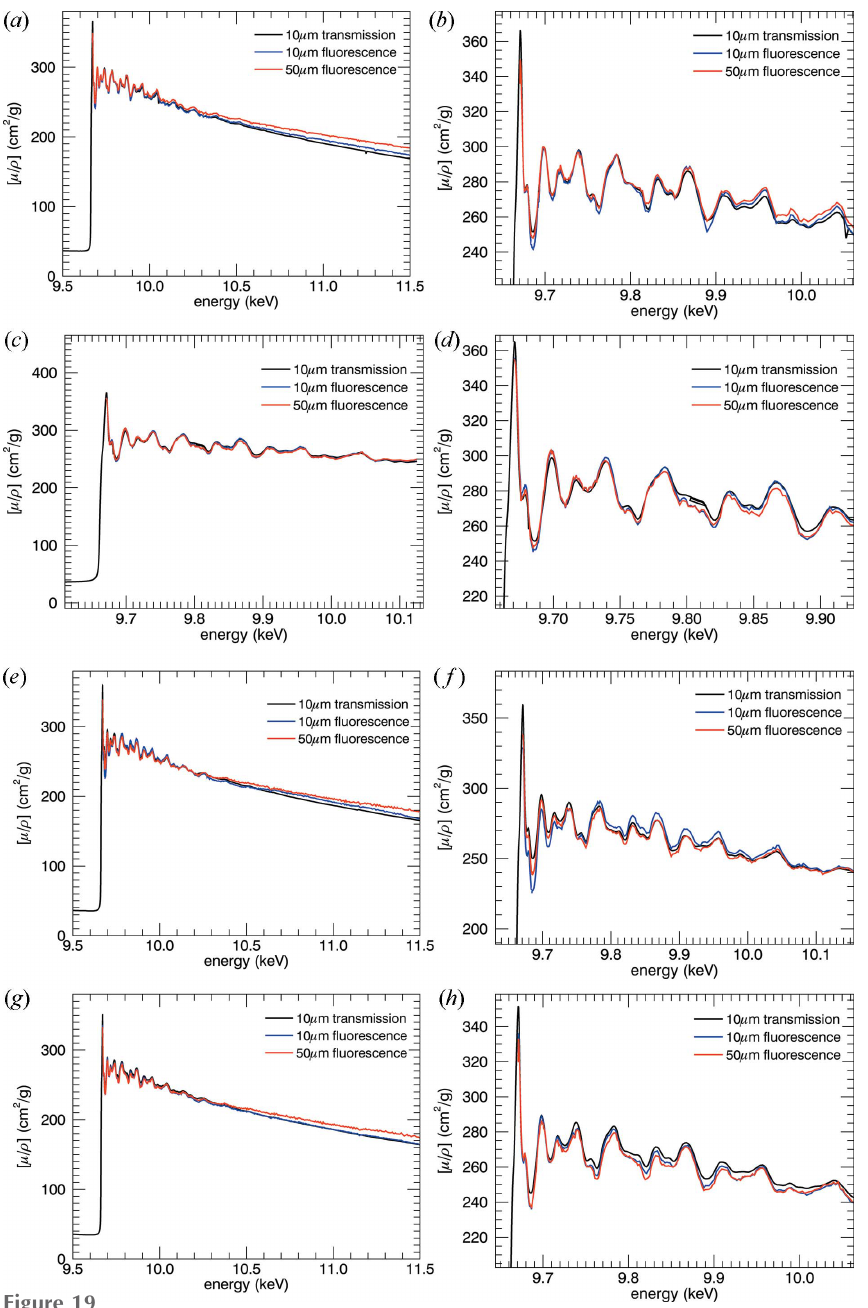
Figure 19 Results from modified SeAFFluX after rescaling and averaging over pixels. From top to bottom: 10 K, 50 K, 100 K, 150 K. The fine structure of the XAFS (right) matches perfectly with small overarching deviations due to the spline fitting. The noise is visibly larger in the fluorescence spectra than in transmission, but all the detail of the XAFS is clearly visible. With careful analysis, just as much structure can be seen in fluorescence analysis as in